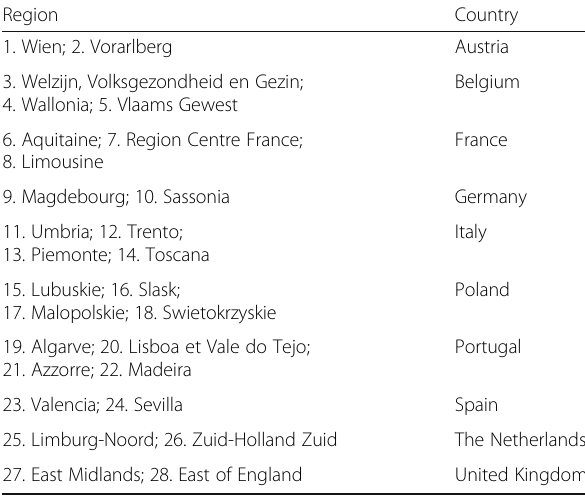
Table 2 Regions and Countries